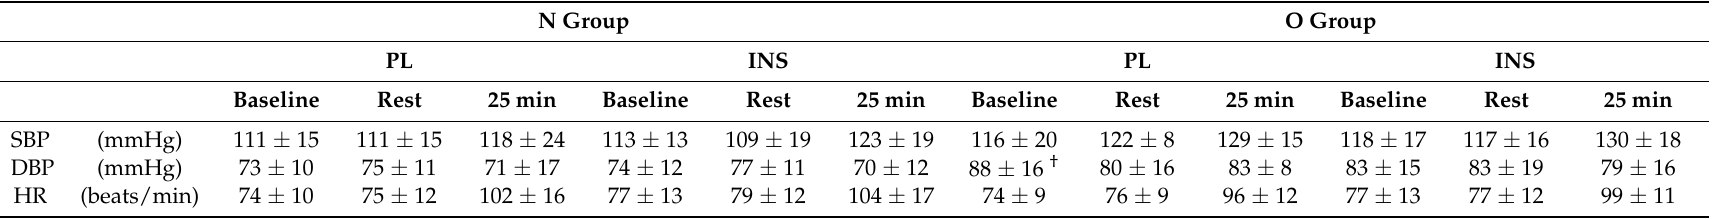
Table 2. Changes in blood pressure and heart rate by intranasal administration and during graded exercise.